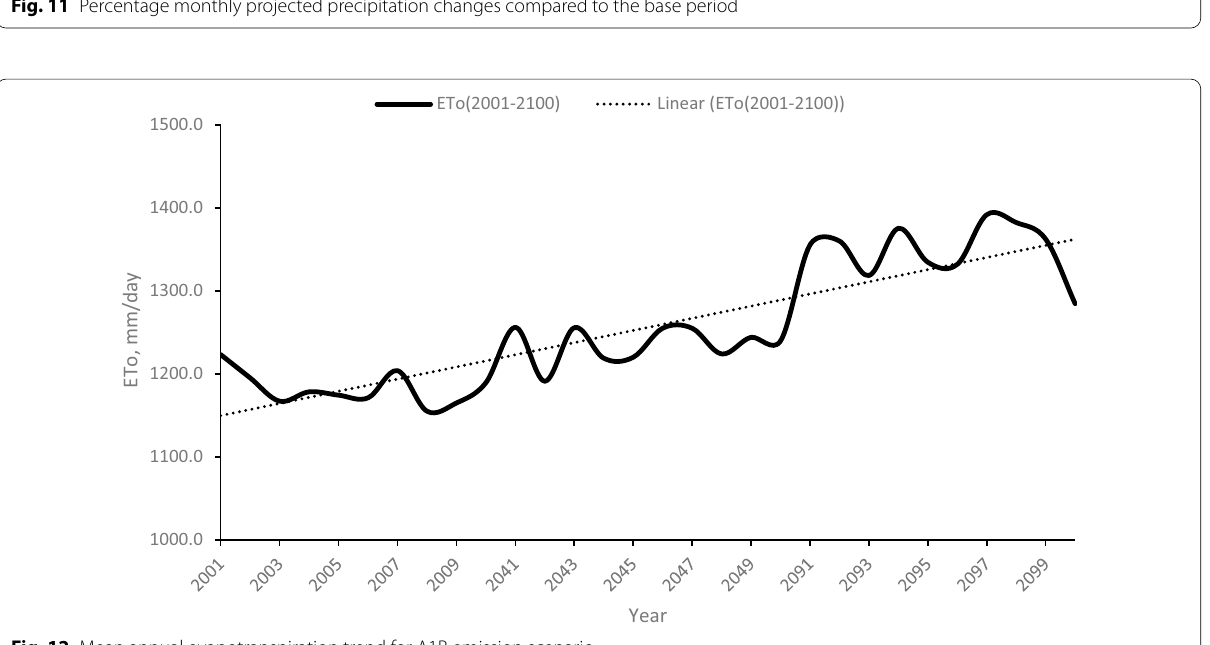
Fig. 11 Percentage monthly projected precipitation changes compared to the base period